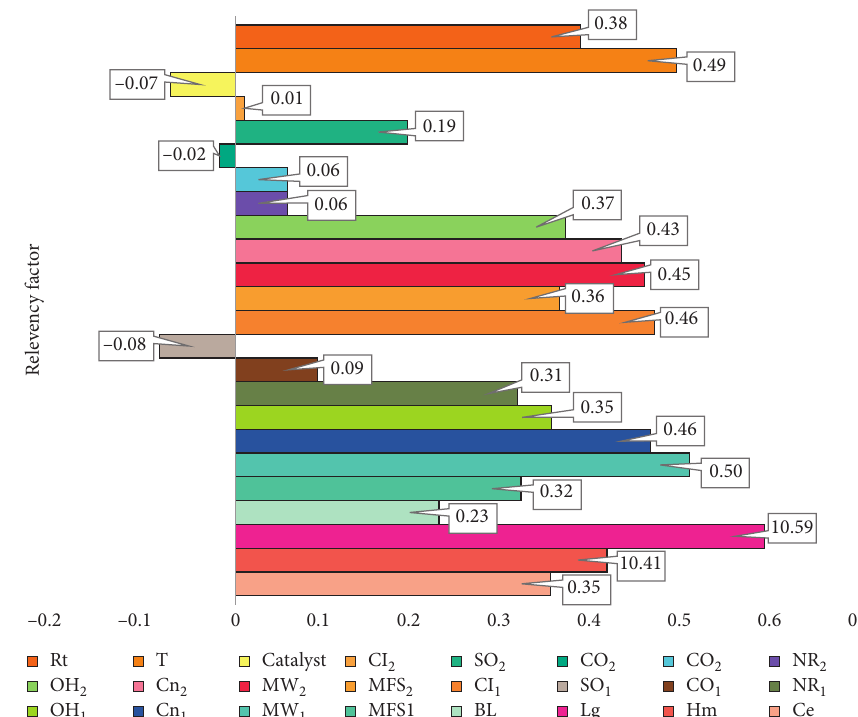
Figure 2: Sensitivity of parameters affecting the output parameter